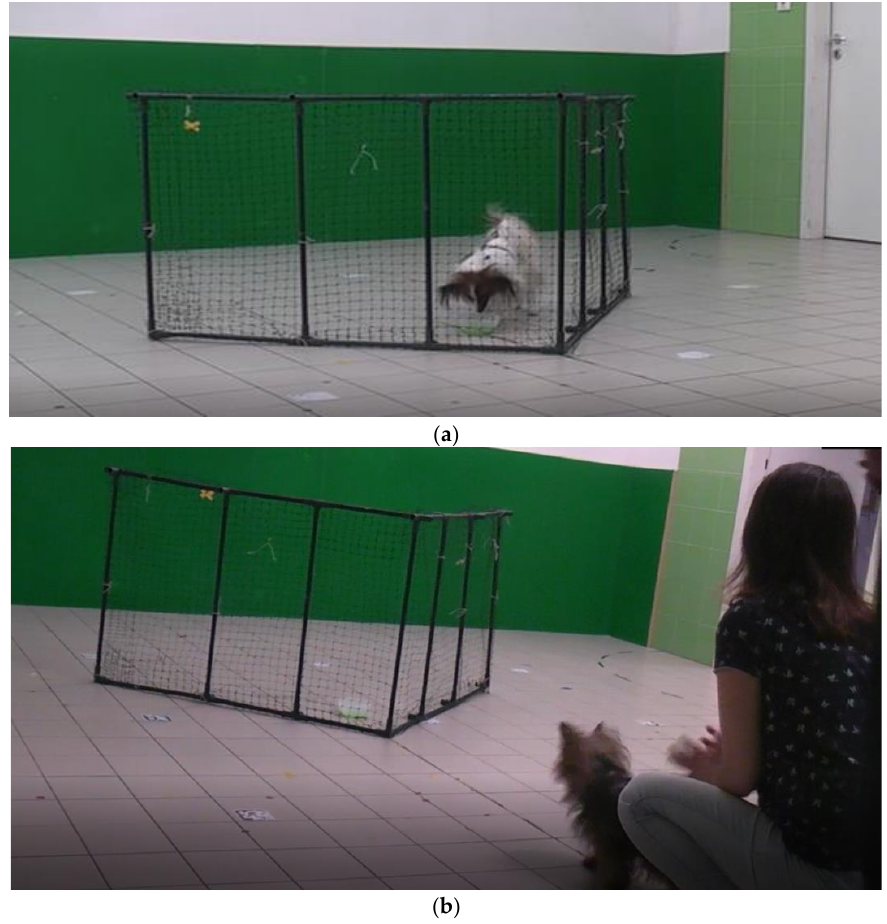
Figure 1. Transparent V-shaped fence (height = 0.5 m, length = 1.5 m, 90-degree angle at the inter- section. A dog arrives at the target behind the fence ( a ). A dog is released by its owner. The relative position of the starting point to the fence is visible ( b